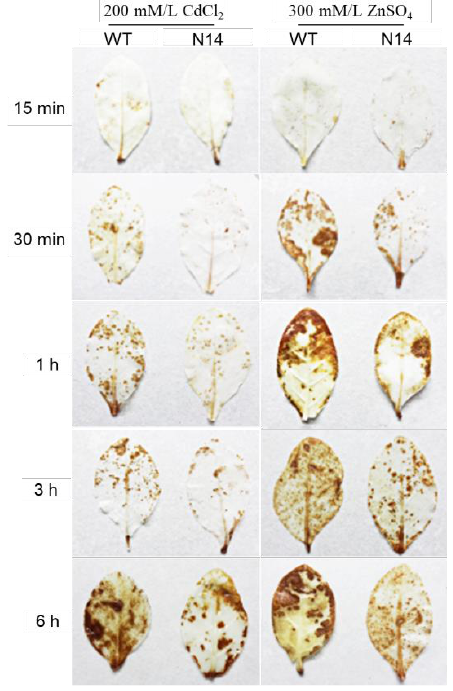
Figure 7. Production of hydrogen peroxide detected by DAB staining under Zn 2+ or Cd 2+ stress. DAB staining of WT and N14 leaves subjected to 200 mM/L CdCl 2 , 300 mM/L ZnSO 4, or 30 mM/L H 2 O 2 for 15 min, 30 min, 1 h, 3 h, or 6 h, respectively. WT: Wild-type tobacco. N14: homozygous transgenic tobacco line (T 2 ). Asterisks indicate the significant difference between transgenic lines and WT.